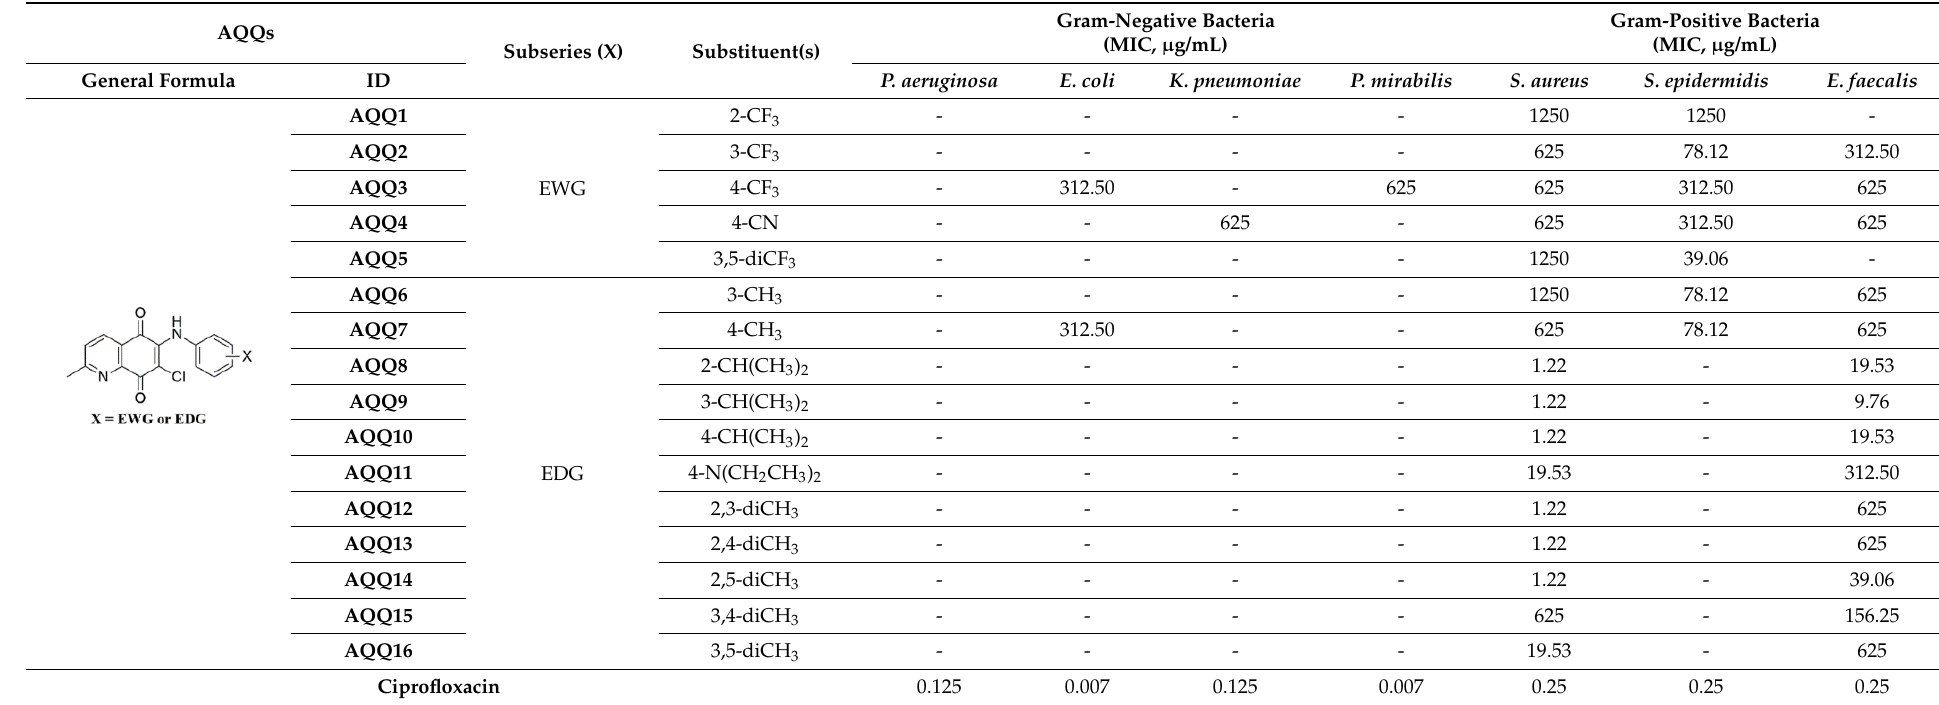
Table 2. The minimal inhibitory concentration (MIC) values of the AQQs ( AQQ1 – 16 ) for antibacterial activity a .